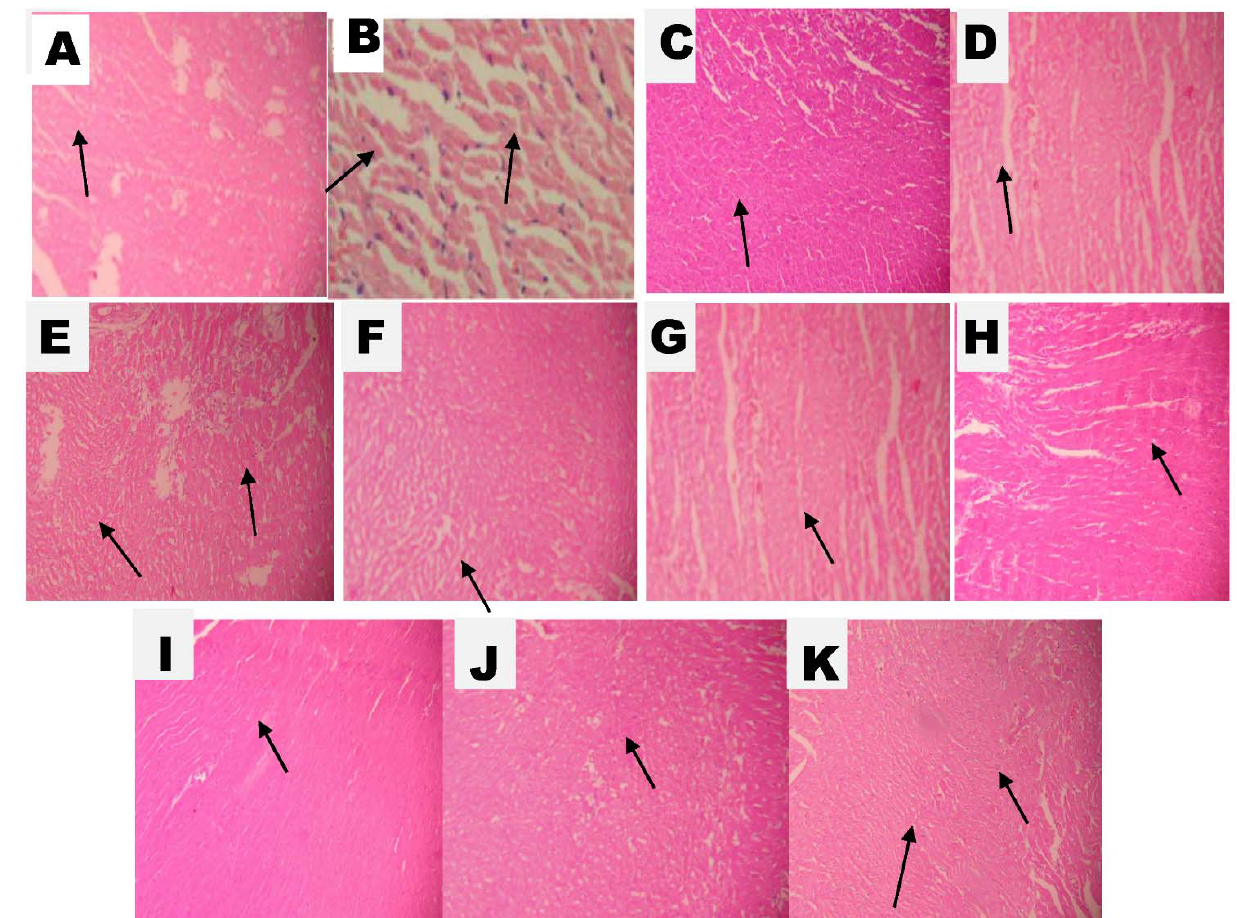
Figure 9. Effect on histopathological score.